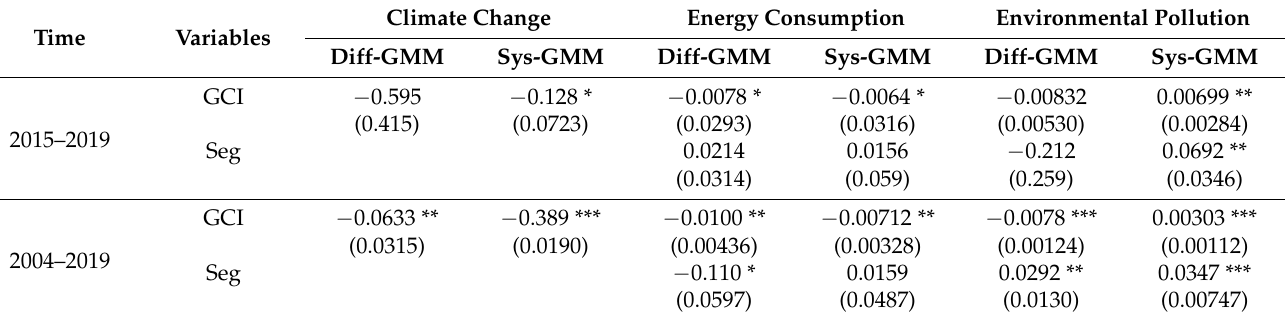
Table 10. Time heterogeneity analysis